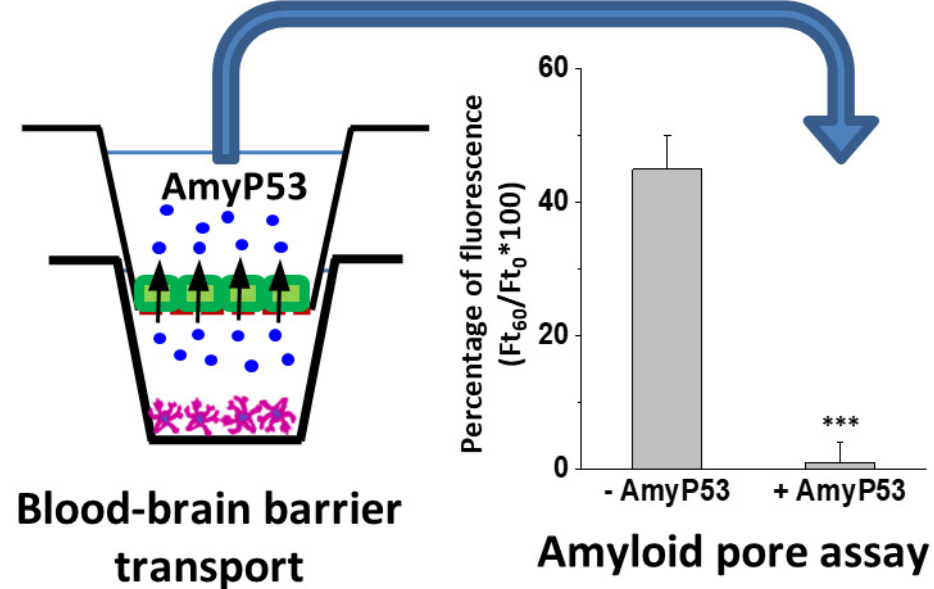
Figure 7. Therapeutic efficiency of AmyP53 recovered after blood–brain-barrier transport (bEnd.3/C6 model). AmyP53 was injected in the donor compartment and recovered from the acceptor compartment after 24 h of incubation ( left panel ). Samples were tested in the amyloid pore assay ( right panel ) in presence of A β 1-42. Control supernatants ( − AmyP53) did not inhibit the Ca 2+ flux triggered by A β 1-42, whereas AmyP53 transported through the reconstituted blood–brain barrier (+AmyP53) was fully active. Data are expressed as mean ± SD (n = 6); *** indicates p < 0.005 (Kruskal–Wallis test).